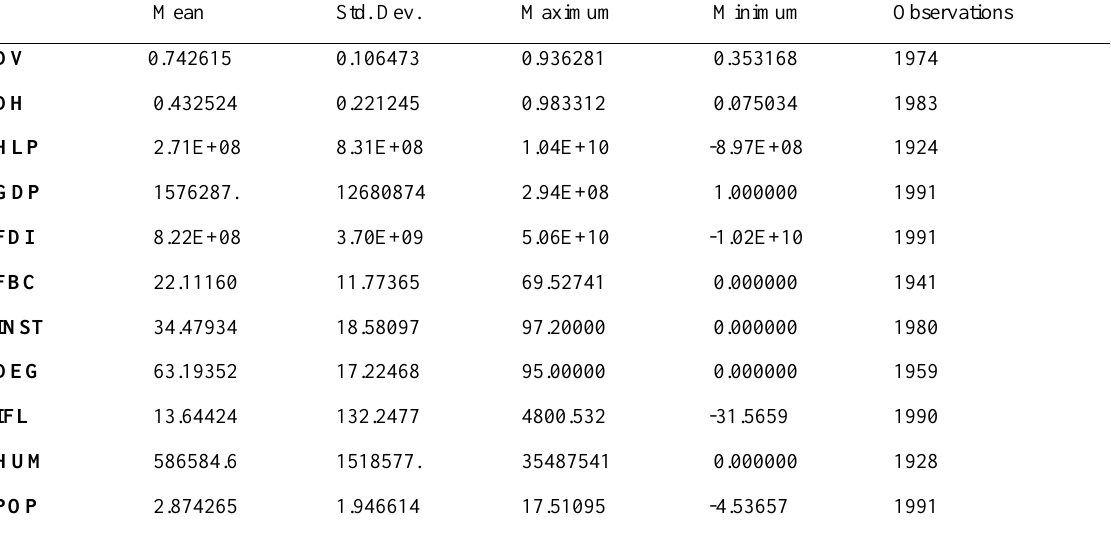
Table 1: Descriptive for the two country